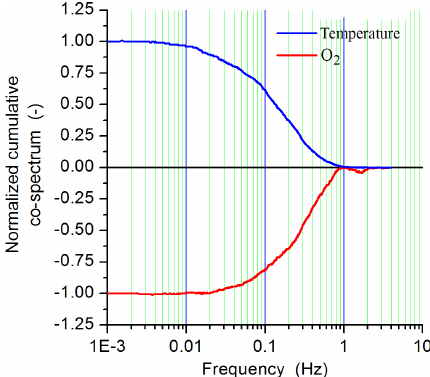
Figure 4. Nighttime normalized cumulative co-spectra for the ver- tical velocity combined with the O 2 concentration and the tempera- ture, respectively, revealing which frequencies carried the eddy flux signal.